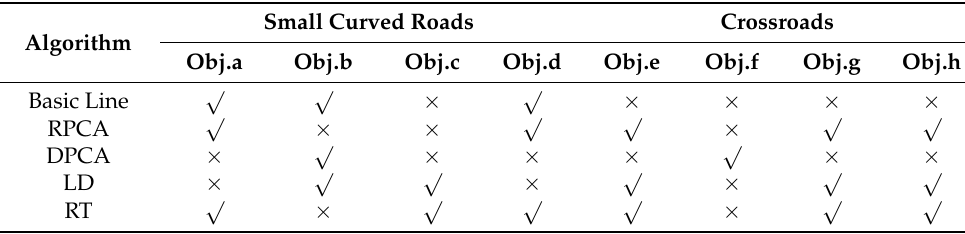
Table 1. Evaluation results of the pose estimation. The True mark indicates that its pose estimation was acceptable. The False mark indicates that there was a large error in its pose estimation. Obj.a– Obj.h corresponds to the obstacle number in each part of Figure 13.